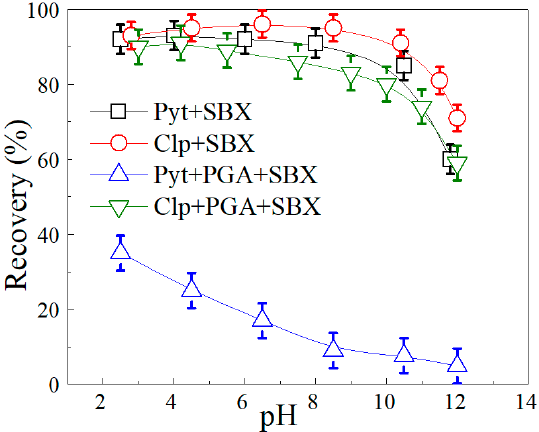
Figure 4. Flotation results of pyrrhotite (Pyt) and chalcopyrite (Clp) at 40 mg / L polyglutamic acid (PGA) and 20 mg / L sodium isobutyl xanthate (SBX).